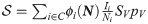
Flowchart for the SI model of T. cruzi transmission in a community of competent and non-competent hosts.Species i = 1 to 4 that are competent hosts (at the top) and vectors (in the middle) are made of susceptible (green) and infectious (red) individuals. Species 5 represents non-competent hosts (at the bottom) so that all individuals always remain susceptible (green). Arrows represent birth, death, migration and infection processes according to the parameters defined in the main text and Table 1. Continuous and dotted lines correspond to demographic and transmission processes. For simplicity, we used the notations S=∑i∈Cϕi(N)IiNiSVpV and T=ϕi(N)SiNipiV.